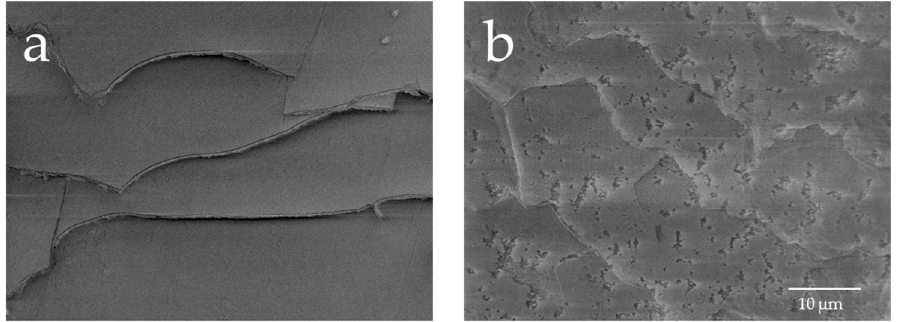
Figure 6. FE-SEM observations of the surface layer of human hair immersed in a Fenton reaction solution. Image of the surface of hair immersed in water and image of the surface of human hair immersed in a Fenton reaction solution. ( a ) Image of the surface of hair immersed in water ( × 2000); ( b ) image of the surface of hair immersed in a Fenton reaction solution ( × 2000).